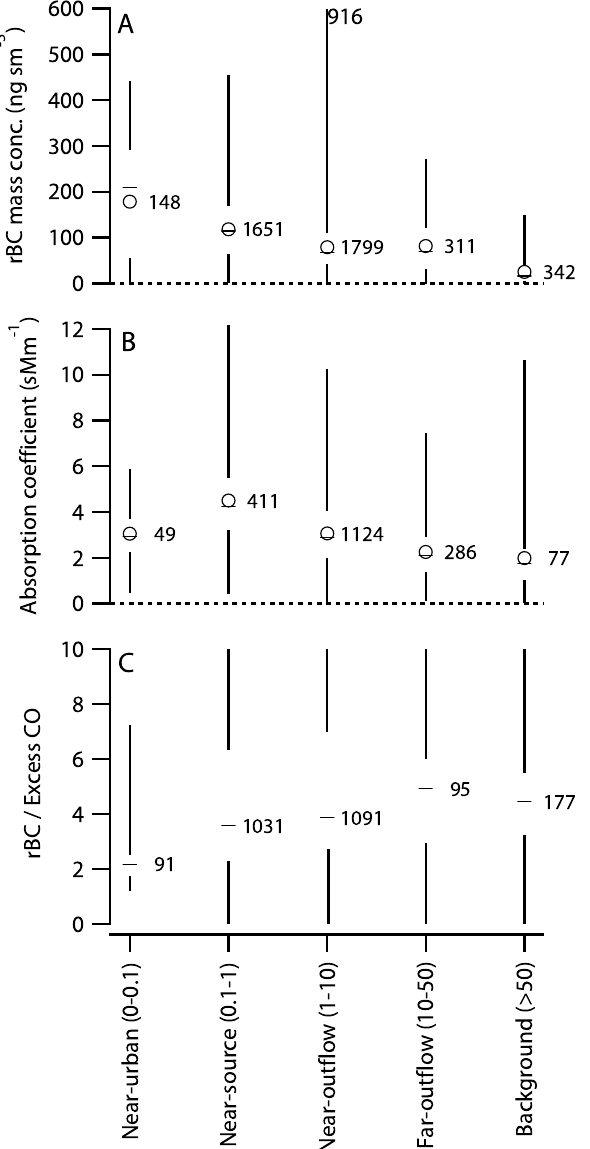
Fig. 11. Whisker plots showing the mean (circles), median (hori- zontal dash), minimum, maximum, 25th and 75th percentiles (ver- tical lines) classified by air mass type for (a) refractory black carbon (rBC) mass, (b) light absorption coefficient at 550nm, and (c) ratio of rBC to excess carbon monoxide mixing ratios (ngsm − 3 /ppbv). Air masses are defined using ratios of O 3 /NO x (listed with air mass label) following Morgan et al. (2010a). The number of individual data points in each bin are given to the right of the data. Maxi- mum rBC/CO ratios are truncated to 10 and only median values are shown due to bias from high ratios associated with variability in the rBC/CO